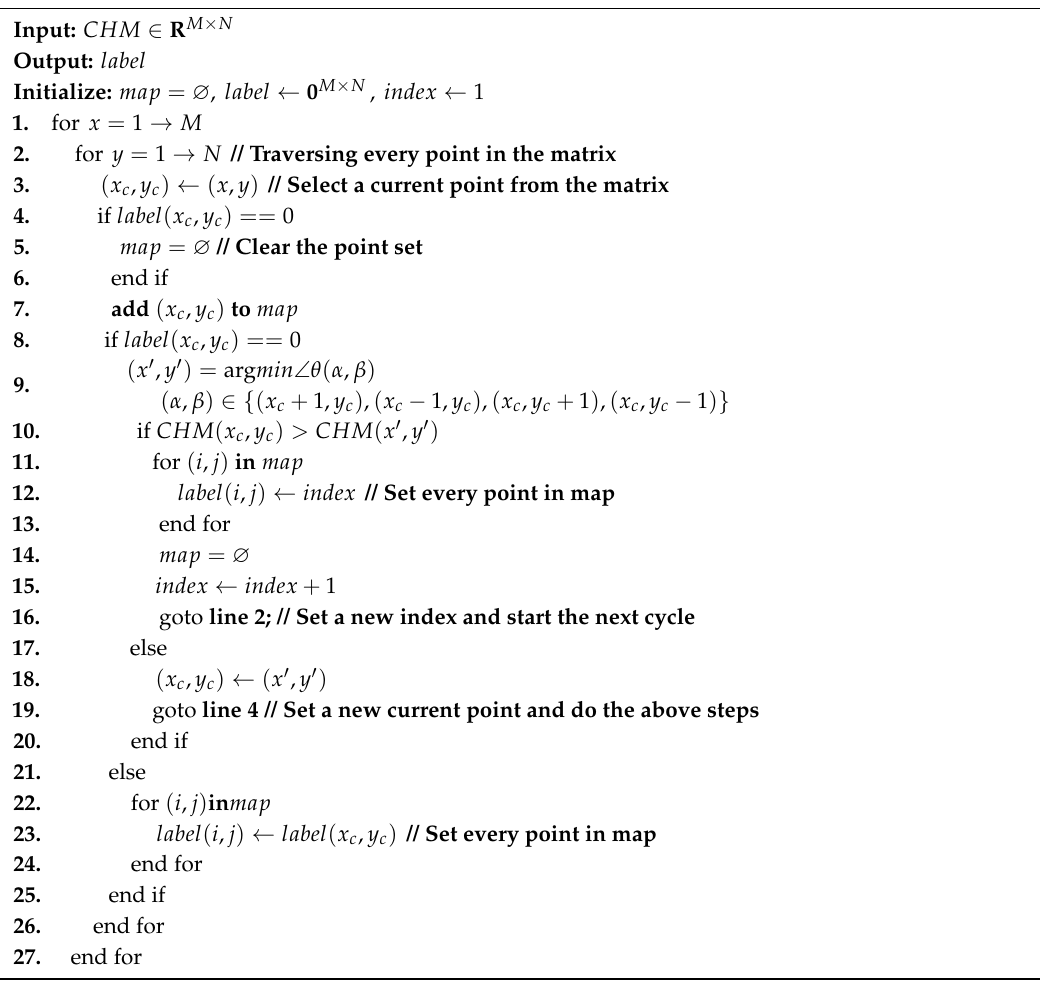
Algorithm 1. Pseudocode of 4-N